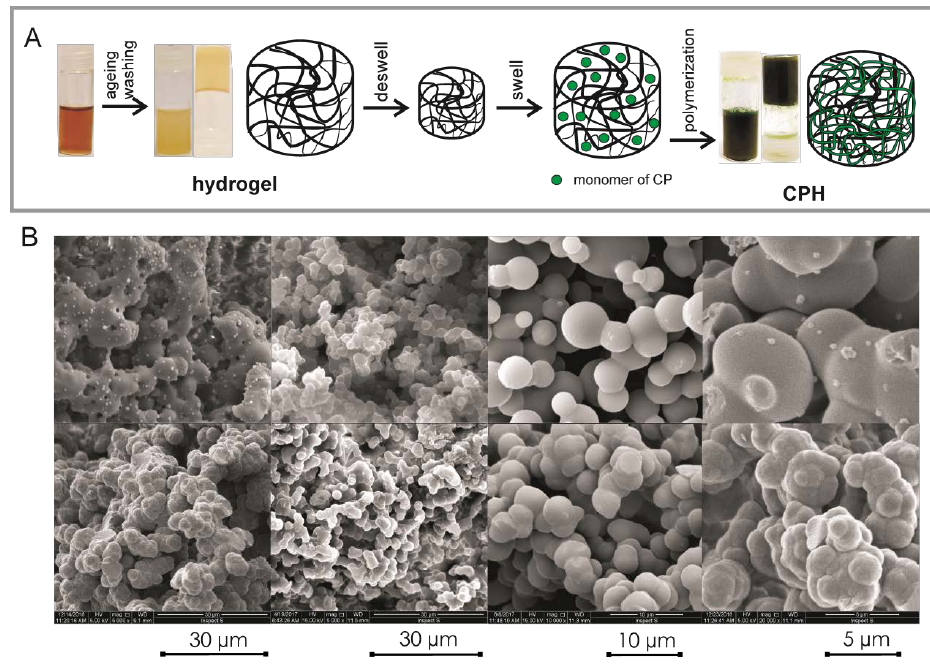
Figure 2. ( A ) Schematic illustration of the synthesis process for a hybrid hydrogel composed of supporting polymer and CPs. The deswelled hydrogel is immersed into the CP solution and absorbs monomers until it reswells to its original volume. Then, the reswelled hydrogel is immersed into a solution containing an oxidative initiator and dopants, allowing the in situ polymerization of CPs. The photos show different stages of hydrogel formation (our results not published). ( B ) Scanning electron microscopic images with different magnifications of aero-sponge like composites formed from different hydrogels (our results not published).